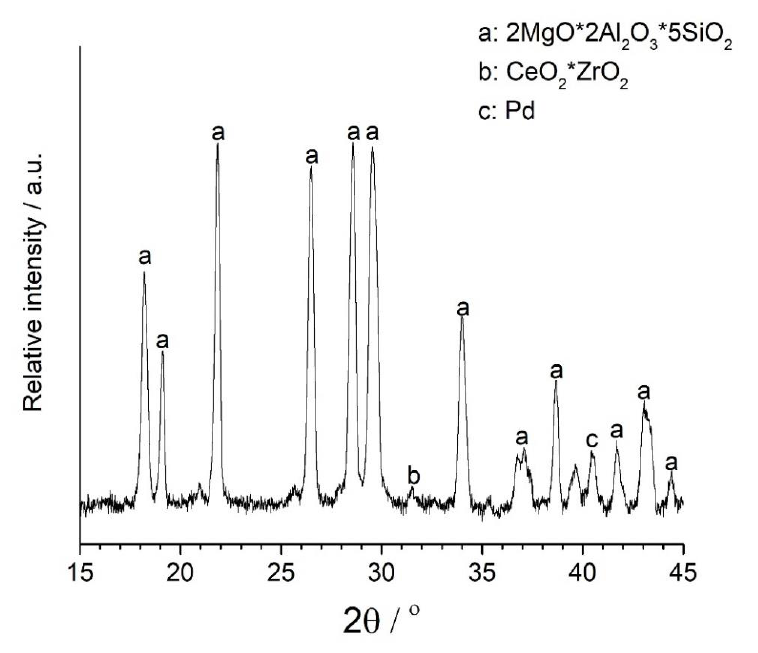
Figure 5. Powder X-ray diffraction of spent automotive catalyst.